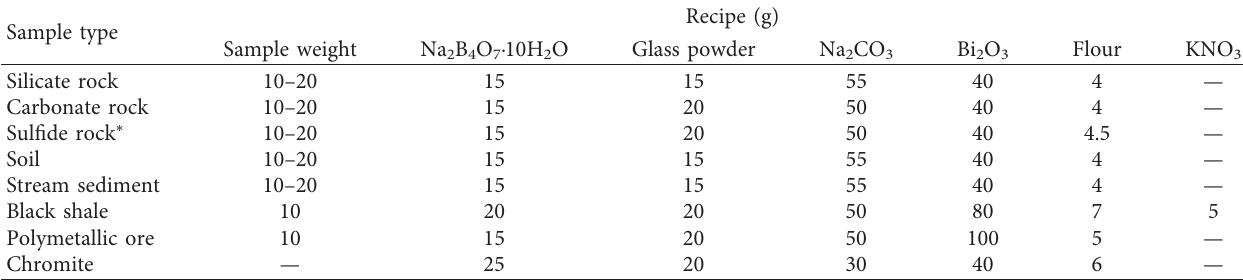
Table 2: Bismuth fire assay recipes for geochemical samples.